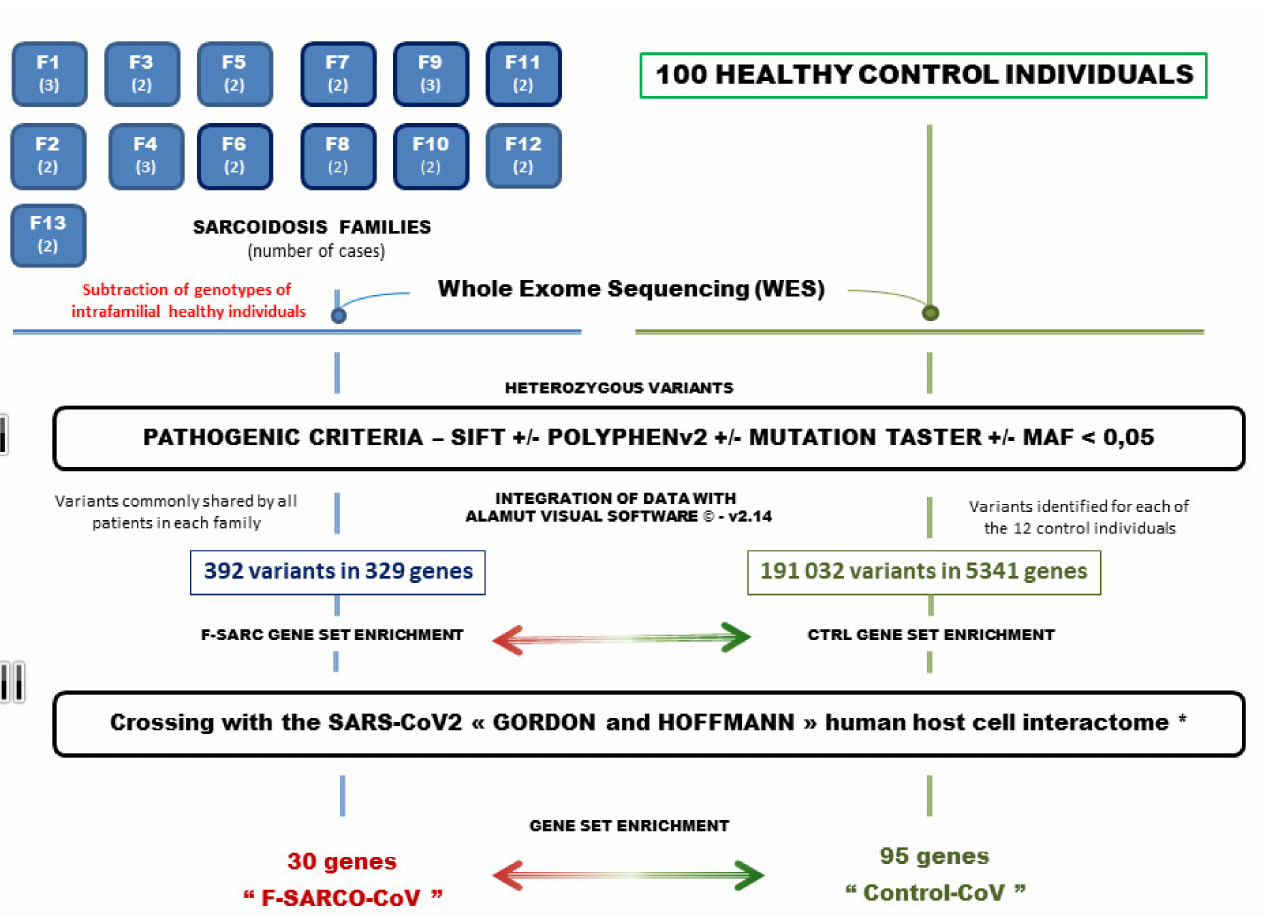
Figure 1. The procedure of gene variant selection in familial sarcoidosis and control individuals. Families F1 to F13 include 2 or 3 affected first-degree relatives (indicated in parentheses). Abbreviations: MAF, minor allele frequency. Alamut Visual TM is an exploration software application for genomic variations from SOPHiA Genetics TM (SOPHiA Genetics Inc., Interactive Biosoftware TM , Boston, MA 02116,